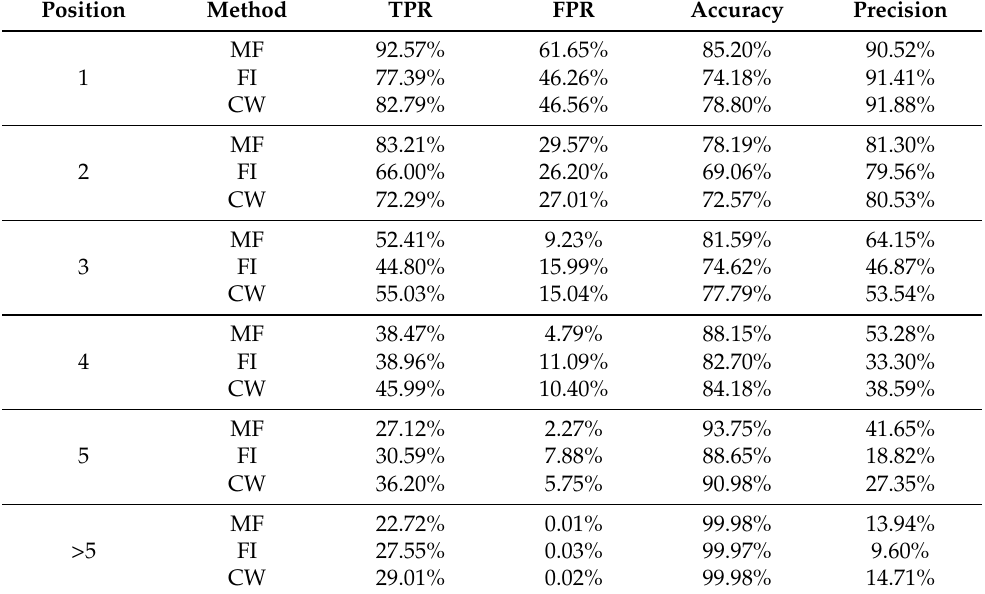
Table 1. TPR, FPR, accuracy and precision comparison across several positions and